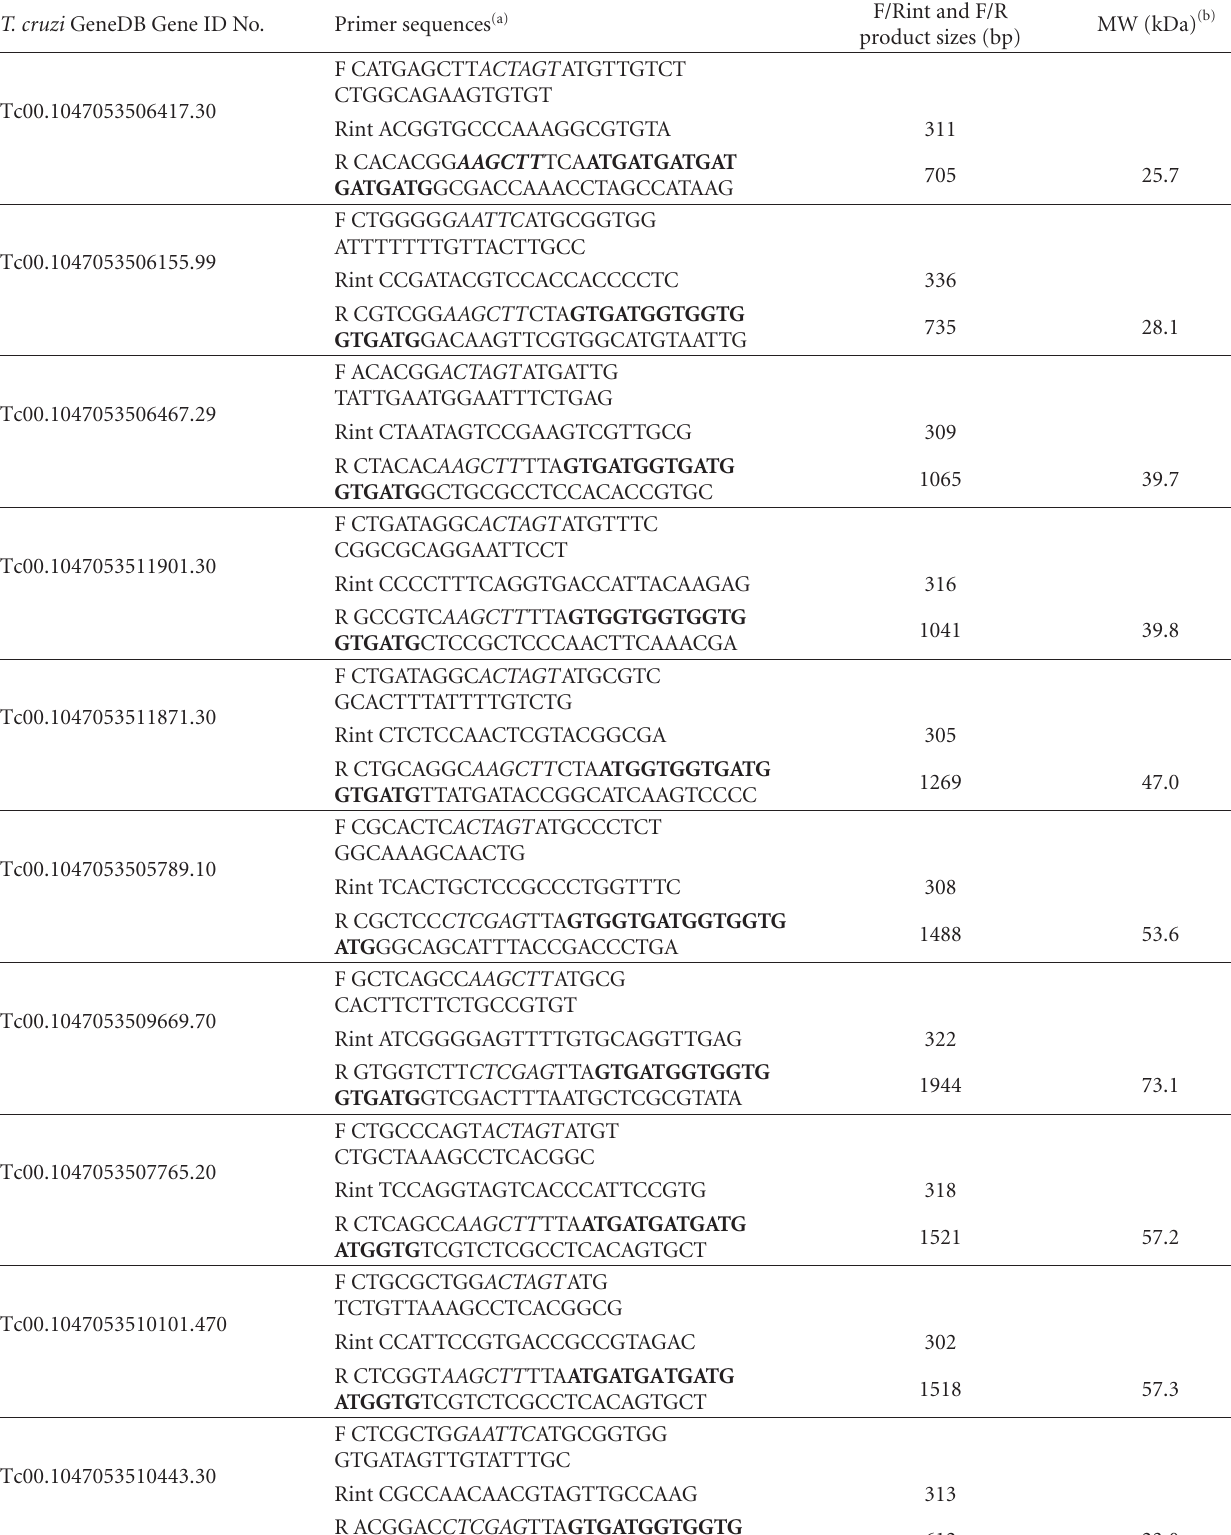
Table 1: Primer pairs designed to amplify the genes encoding the 13 T. cruzi putative secreted proteins conserved in trypanosomatids and T. cruzi Tubulin (negative